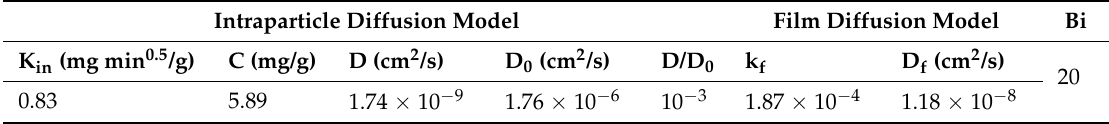
Table 6. Parameters of film and intraparticle diffusion models for copper uptake on olive